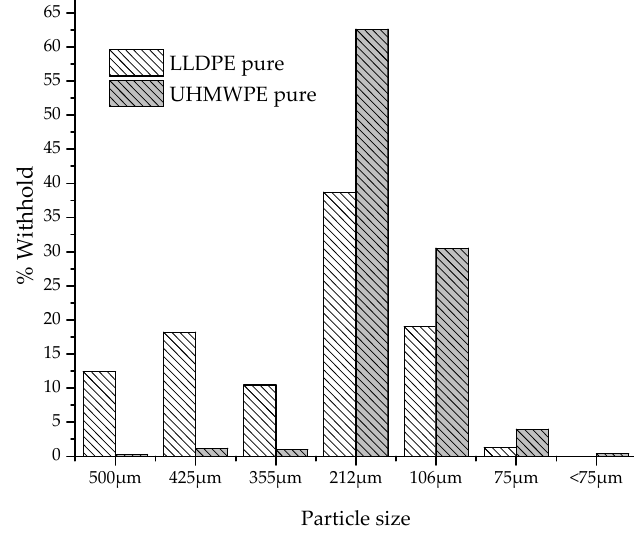
Figure 2. Particle size distribution of LLDPE and UHMWPE.